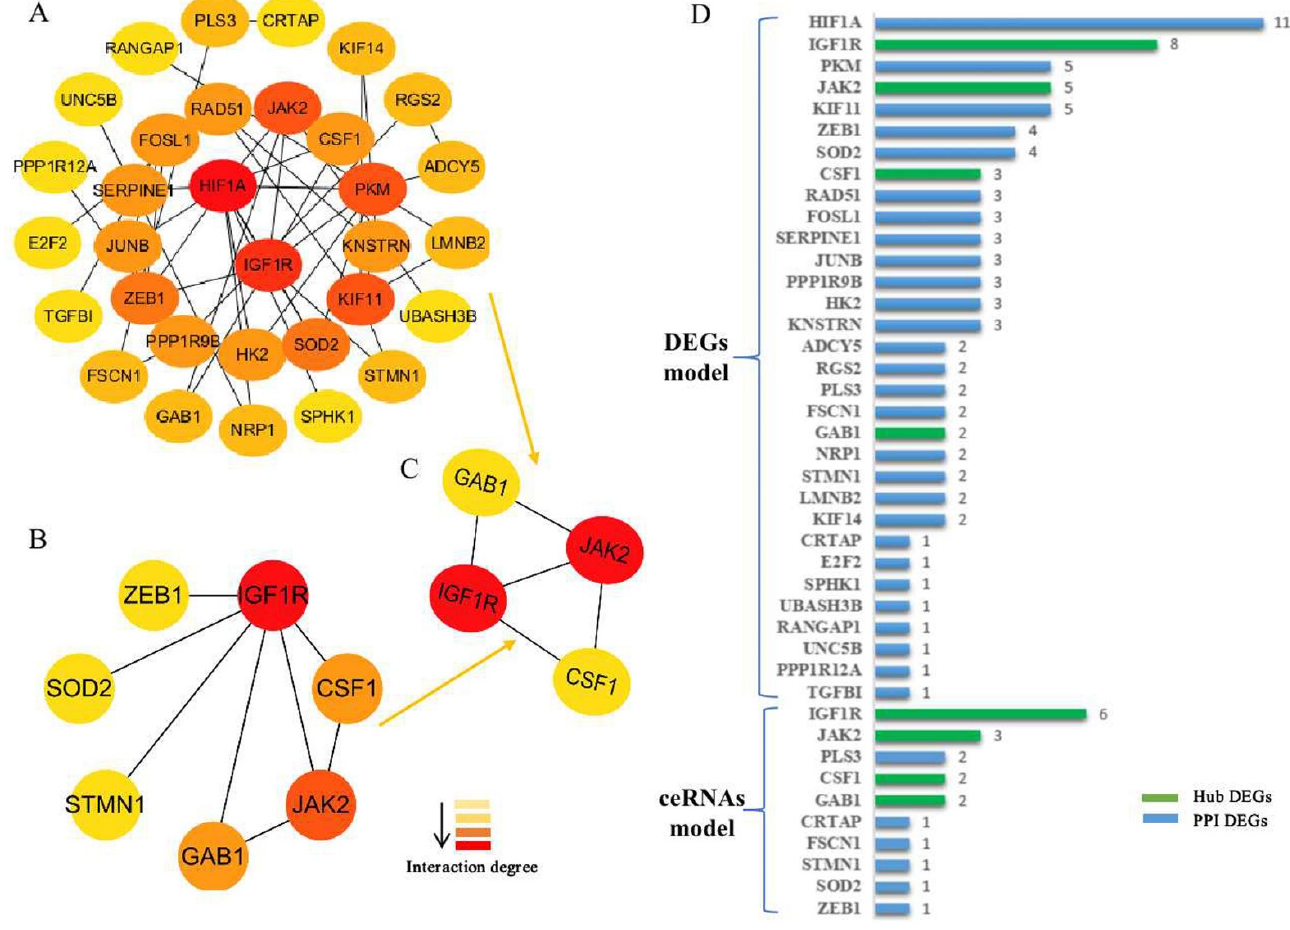
Figure 4. The protein–protein interaction (PPI) network constructed via the STRING database for the DEGs. ( A ) PPI network of the 79 co-mRNAs. ( B ) PPI network of the 26 ce-mRNAs. ( C ) The top modules networks were identified by Cytoscape MCODE. Both the 79 co-mRNA and the 26 ce-mRNA list showed the same top modules. The shades of color (yellow to red) represent the degree to which the molecules interact. ( D ) Genes from the DEGs (co-mRNAs and ce-mRNAs) based on the PPI network analysis with the degree of interaction in the PPI network hub nodes.